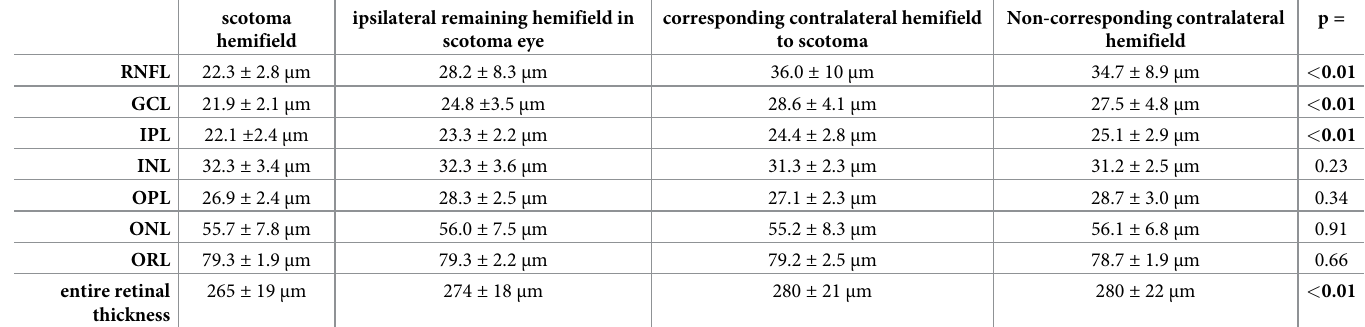
Table 3. Hemifield analysis in the glaucoma group. Mean thickness of the retinal layers and the entire retina. Results are shown for the hemifields corresponding to the localization of the absolute scotoma in the visual field, the opposite hemifield of the ipsilateral eye, and the superior and inferior hemifield of the contralateral eye.